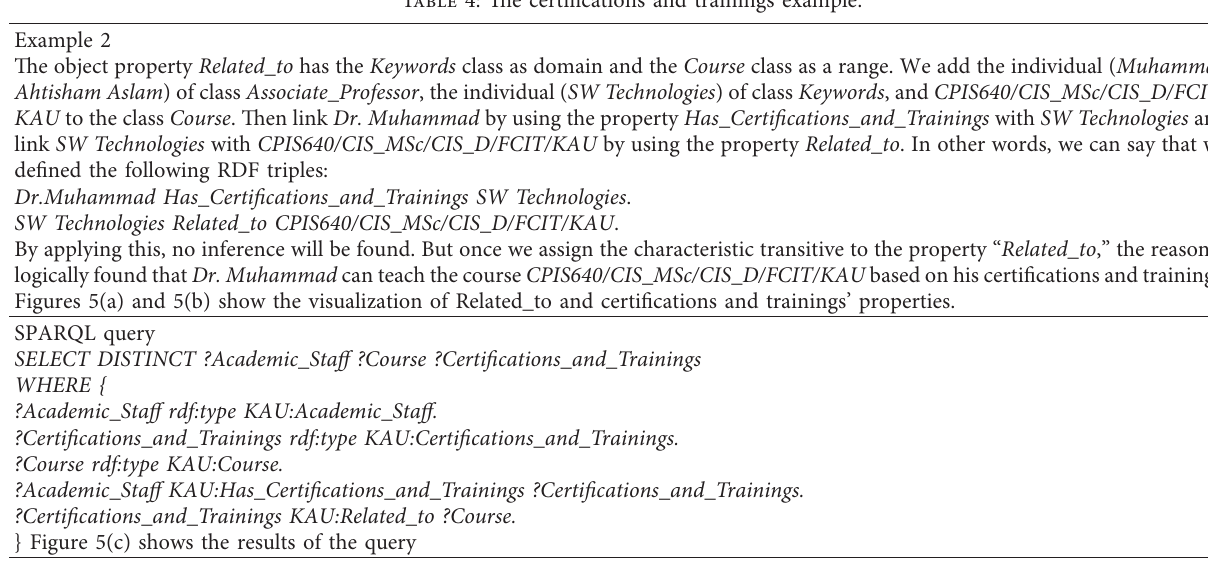
Table 4: The certifications and trainings example.